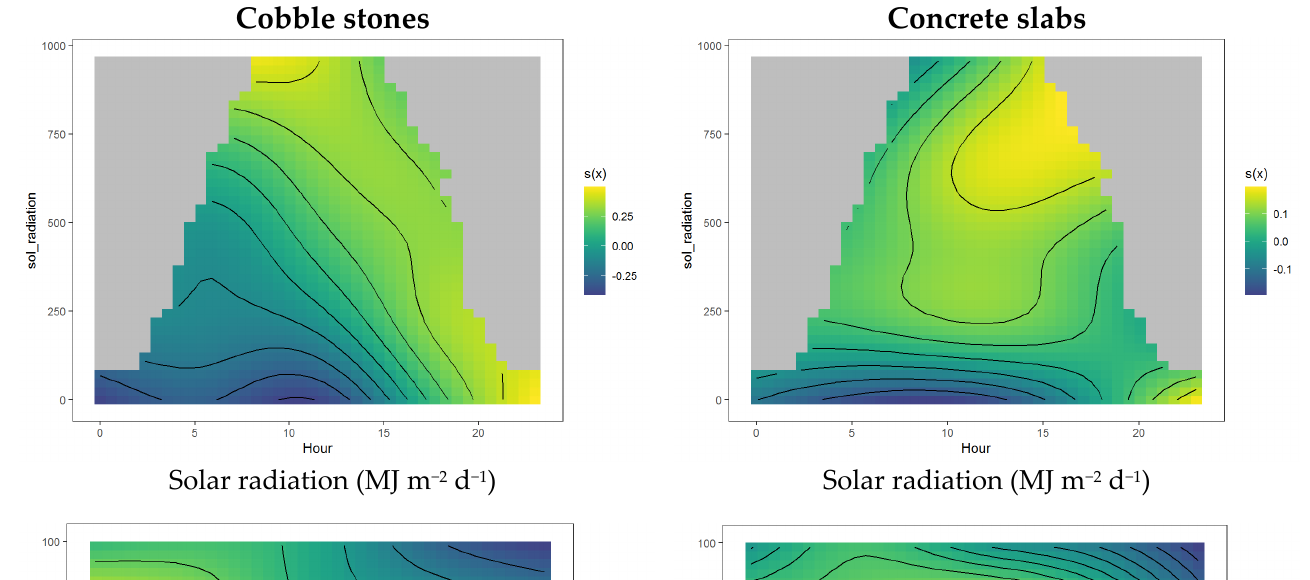
during the day but also at nighttime.